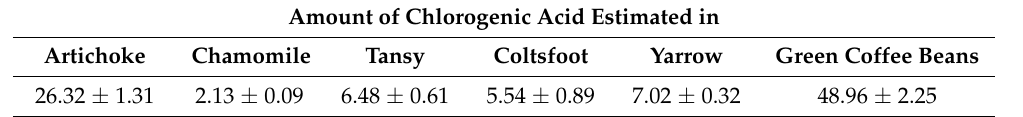
Table 2. Amount [mg/g] of chlorogenic acid estimated in the plants by the SSDM method in combination with the IP–SPE procedure (mean value ± SD). Amount of Chlorogenic Acid Estimated in Artichoke Chamomile Tansy Coltsfoot Yarrow Green Coffee